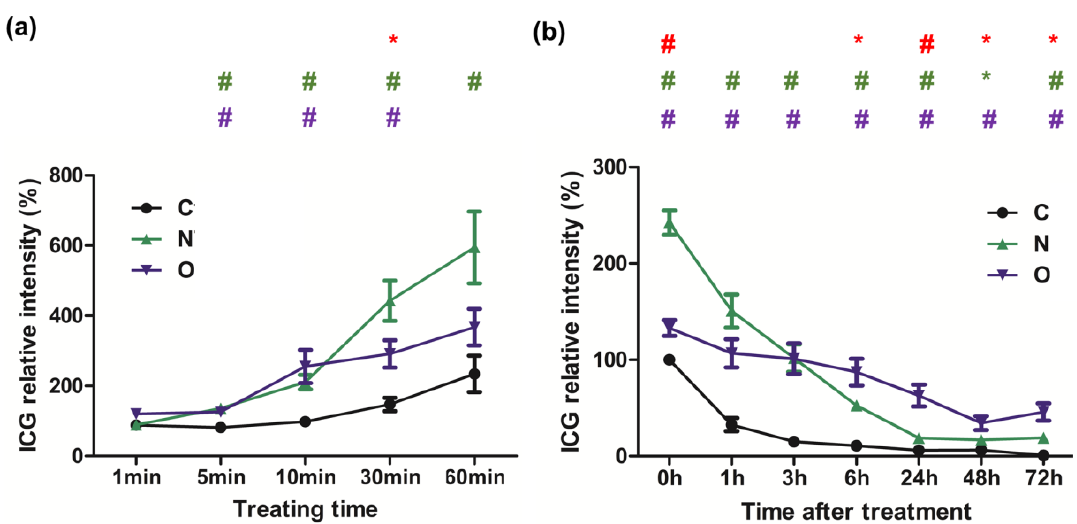
Figure 2. ICG intake and retention in NTCP - and OATP1B3 -expressing HT-29 cells. ( a ) ICG intensity was detected after ICG treatment for 1, 5, 10, 30, and 60 min in the control and the NTCP - and OATP1B3 -expressing HT-29 cells. N = 3. ( b ) ICG intensity was detected at 0, 1, 3, 6, 24, 48, and 72 h after ICG treatment for 1 h in the control and NTCP - and OATP1B3 -expressing HT-29 cells. N = 3. C: control HT-29 cells. N: NTCP -expressing HT-29 cells. O: OATP1B3 -expressing HT-29 cells. Error bars represent the standard error of the mean (SEM). * p < 0.05, # p < 0.01. * in purple color indicates control compared with OATP1B3 -expressing HT-29 cells. * and # in green color indicate control compared with NTCP -expressing HT-29 cells. * and # in red color indicate NTCP -expressing HT-29 cells compared with OATP1B3 -expressing HT-29 cells.